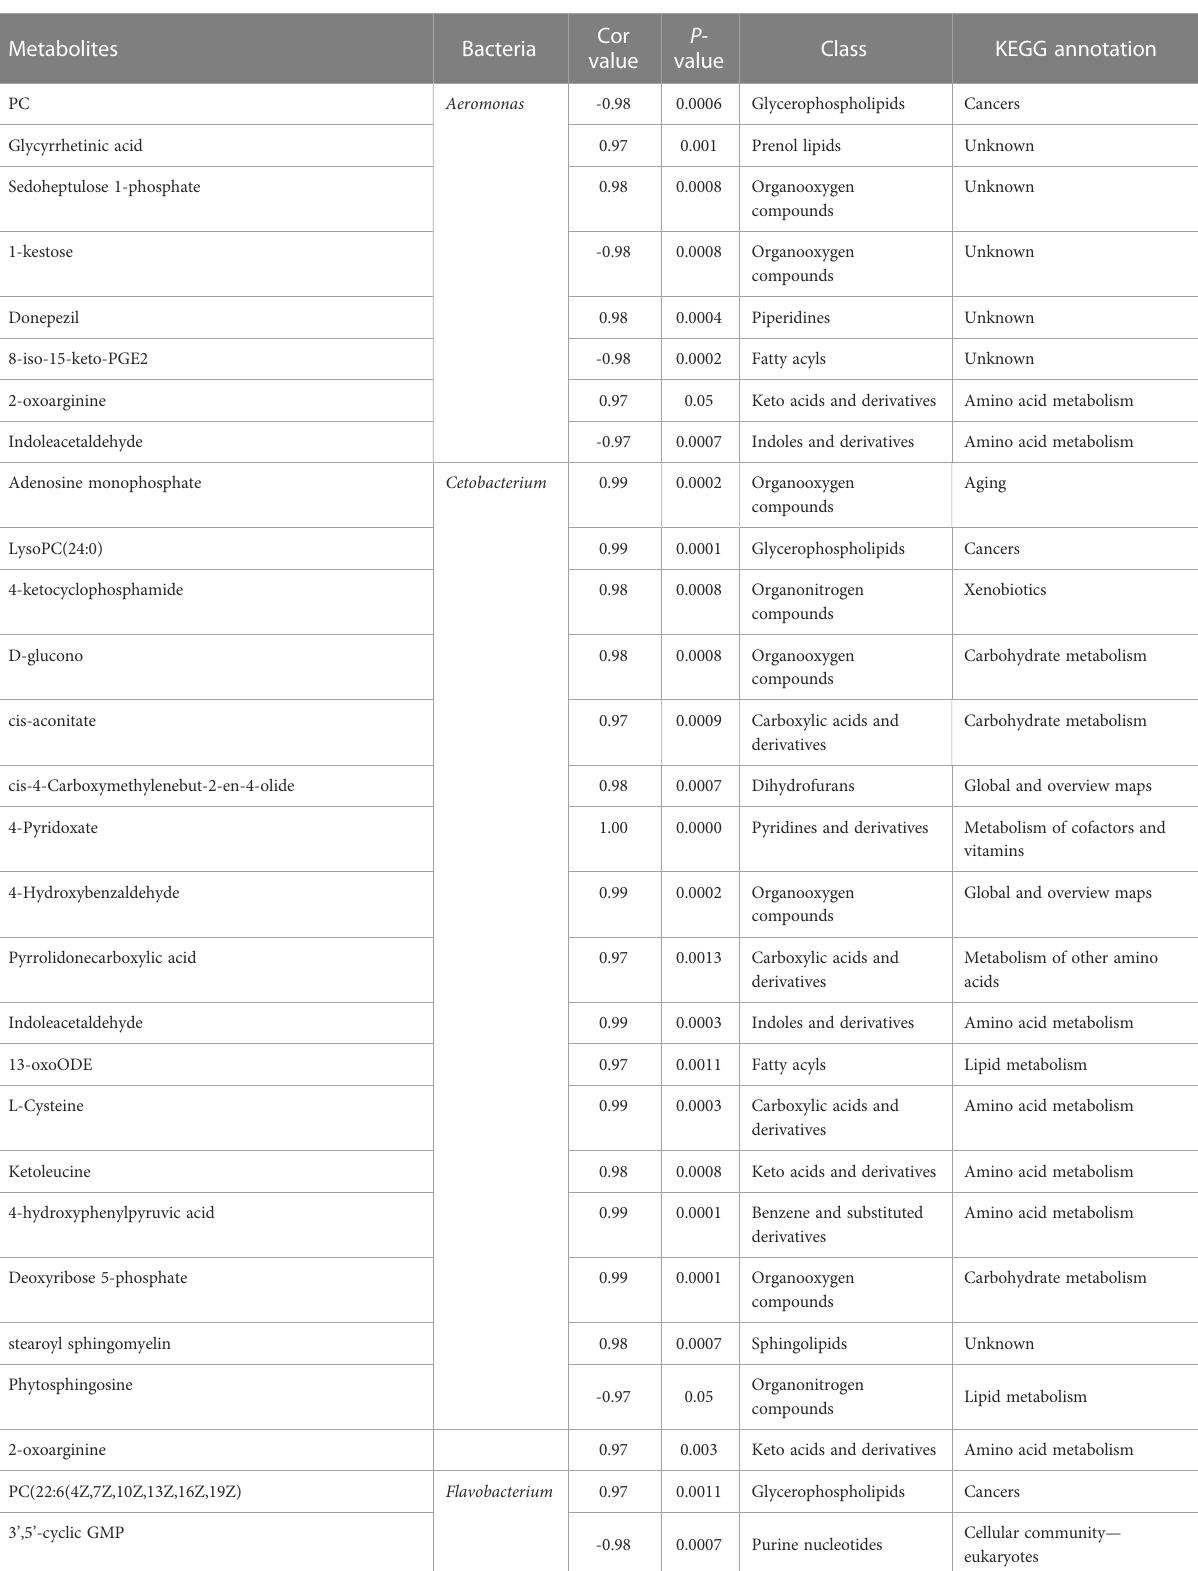
TABLE 2 The correlation between some differentially speci fi c microbes and